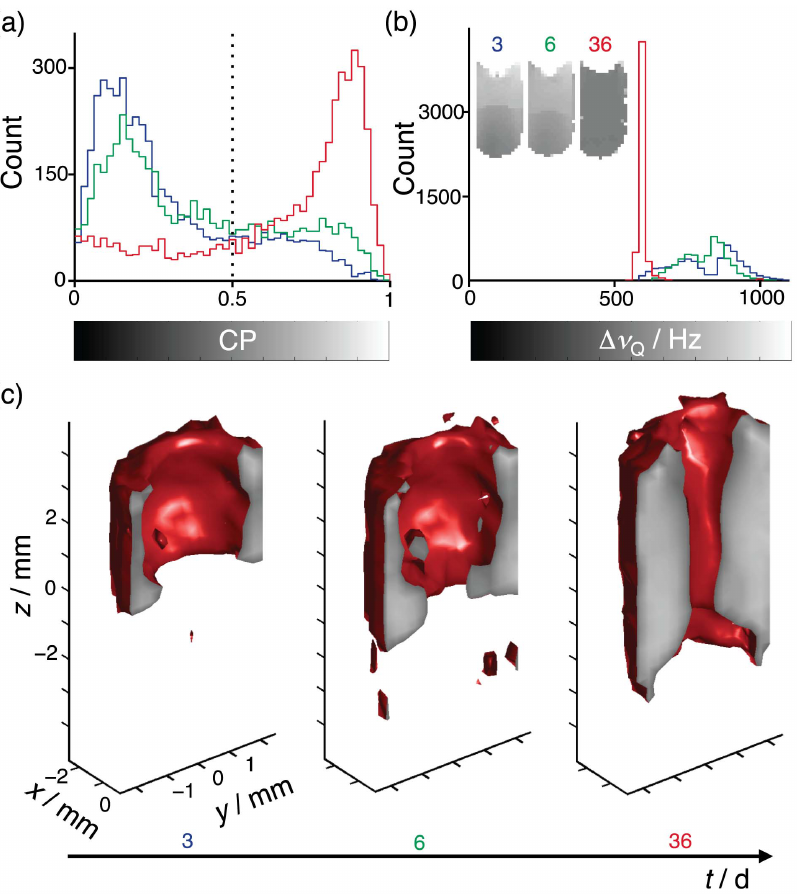
Figure 8. Time-resolved 3D mapping of the formation of a macroscopically oriented lamellar phase. Panels (a) and (b) show histograms of the planar diffusion anisotropy index CP and the 2 H quadrupolar splitting D n Q at the times t ~ 3 (blue), 6 (green), and 36 (red) days after a temperature quench from 67 to 25 u C. The vertical dashed line in (a) indicates the value of CP for segmenting the 3D image into oriented (CP w 0 : 5 ) and non-oriented (CP v 0 : 5 ) lamellar phase. Insets in (b) show D n Q maps at x ~ 0 , gray-scale coded according to the bar below the D n Q -axis. (c) 3D rendering of the CP ~ 0 : 5 contour (red surface) for the times t ~ 3, 6, and 36 days after the temperature quench. The surface at x ~ 0 indicates the value of CP according to the gray-scale bar in (a).